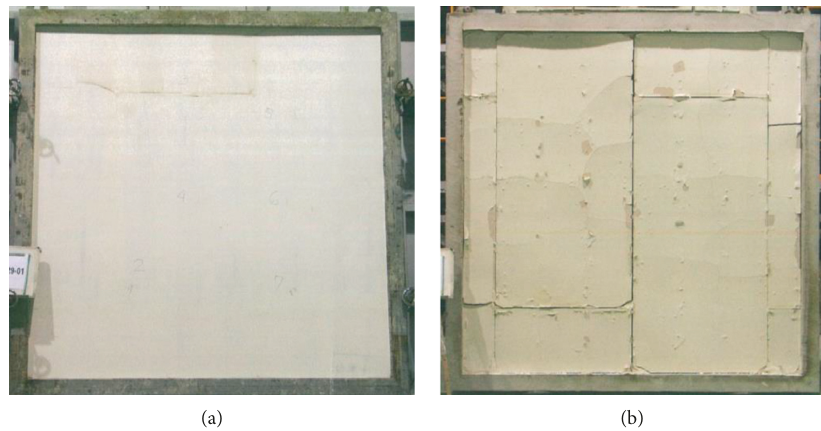
Figure 14: The result of the specimen after 60min standard fire test in Test 1. (a) Unexposed surface. (b) Exposed surface.